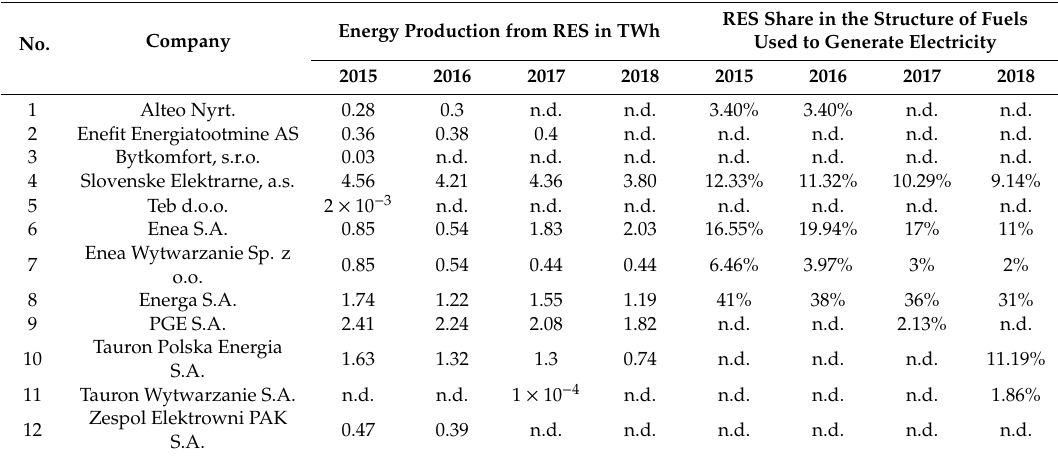
Table 2. Companies using renewable energy sources to produce